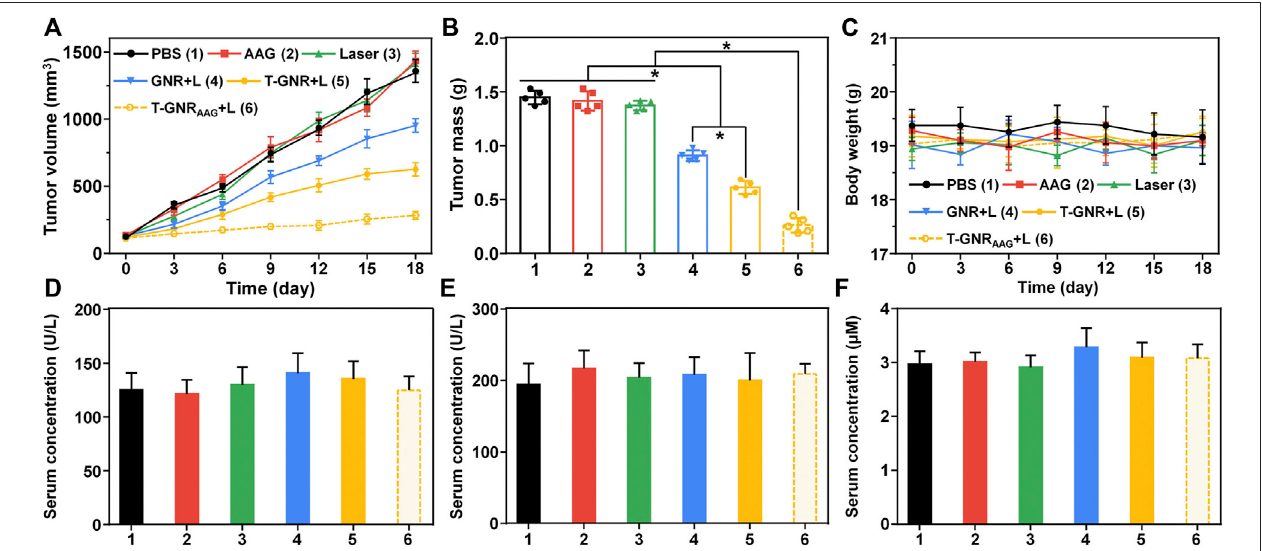
FIGURE7|(A) TumorgrowthinHepG2tumorxenograft-bearingBALB/cnudemicereceivedvariousformulations.The i.v. injectionswereperformedonday0(n= 5). (B) TheHepG2tumormassafterthetreatment(day18).* p < 0.05. (C) Bodyweightchangeofthemiceduringthetherapeuticwindow.ELISAexaminationofALT (D) , AST (E), and BUN (F) in the serum on day